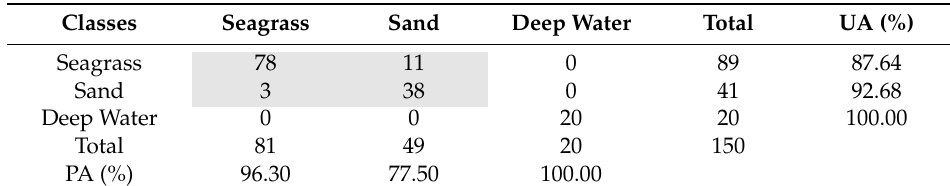
Table 3. The confusion matrix and summary error statistics for seagrass distribution mapped from the Worldview-2 image validated against the field survey data. PA is Producer’s accuracy; UA is User’s accuracy. The gray area shows the confusion between seagrass and sand.